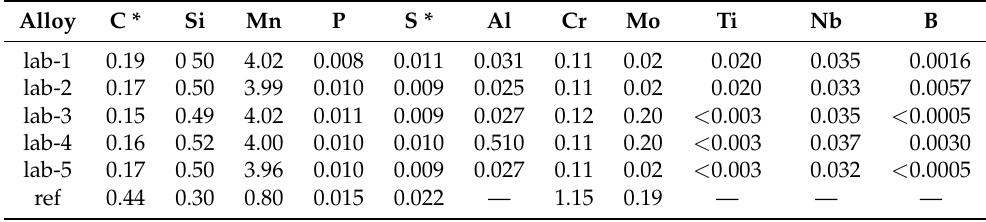
Figure 1. Information on dilatometry testing: ( a ) geometry of cylindrical dilatometry samples with lubrication pockets. ( b ) Time-temperature plot of the dilatometry experiments, with heating rate ˙ T , austenization temperature T a , austenization time t a , deformation temperature T d , holding time before deformation t d , deformation degree (equivalent strain) ϕ , and strain rate ˙ ϕ . Table 1. Chemical composition of the laboratory (lab-1 to lab-5) melts and the reference alloy 42CrMo4 (ref). All concentrations are given in